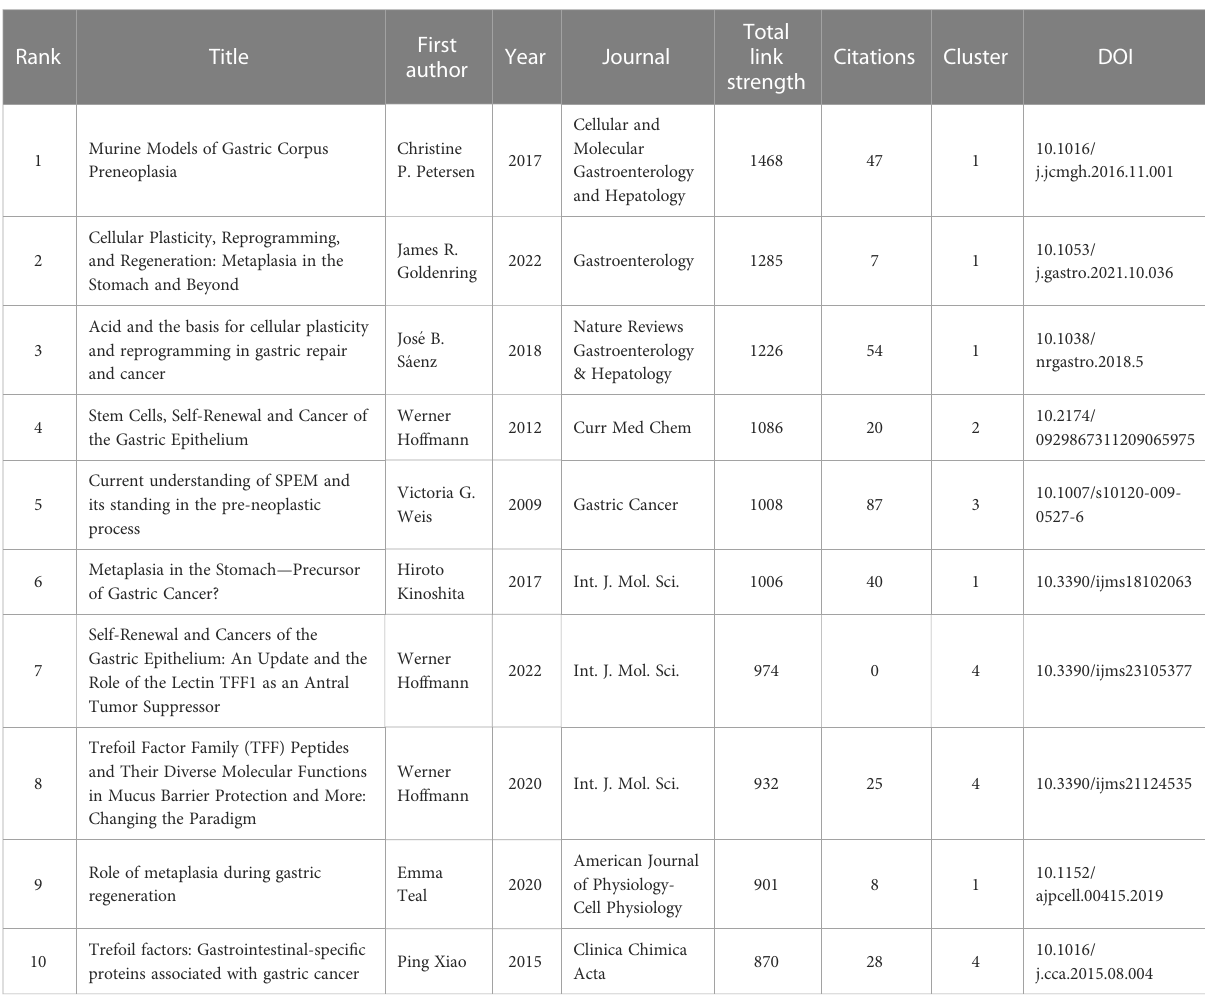
TABLE 5 The top 10 citing references based on total link strength in SPEM-GC research.